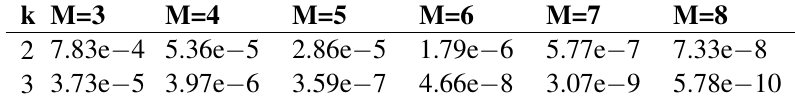
Table 2 L ∞ error under different parameters